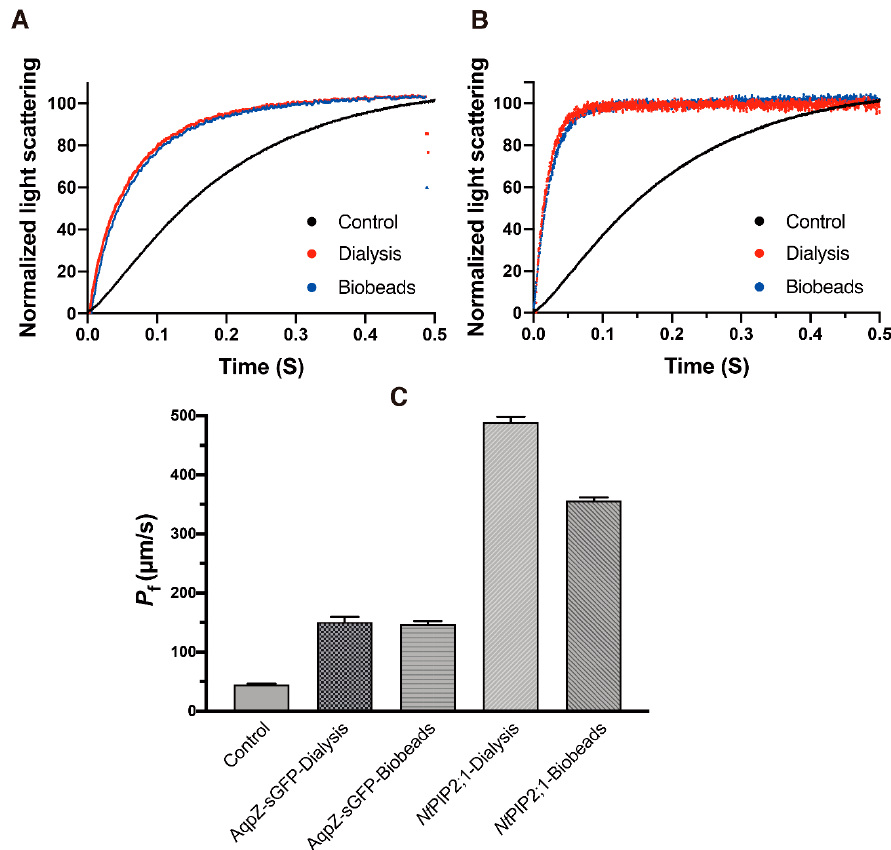
Figure 3. Water permeability of AqpZ-sGFP and Nt PIP2;1 proteo-liposome reformed via a detergent re-solubilization of the L-CFPS produced sample. ( A , B ), normalized and averaged light scattering measurements of AqpZ-sGFP and Nt PIP2;1 proteo-liposome under osmotic shock via a stopped-flow spectrophotometry ( n = 8–10). Red trace, proteo-liposome formed via the step dialysis method; blue trace, proteo-liposome formed via bio-beads; black trace, control empty liposomes. ( C ), bar chart of the calculated water permeability P f (mean ± SD) of corresponding